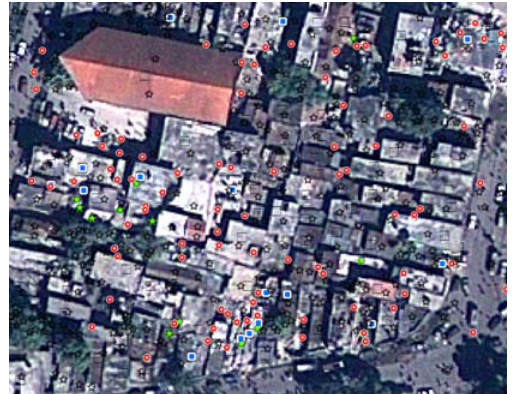
Figure 8 Segment centres classified as collapsed buildings for rule based classification (green star), MaxEnt approach (red circle) and reference data (blue box).